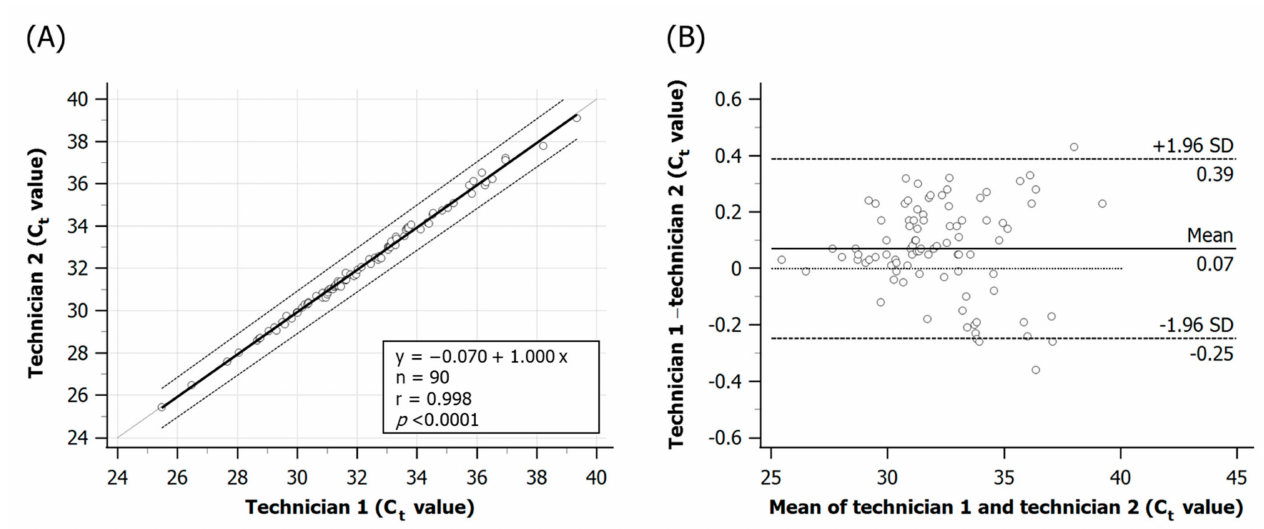
Figure 6. Comparison of the Ct values obtained during the real-time PCR analysis, performed by two technicians, using the spleen sample of red sea bream iridovirus (RSIV)-infected rock bream fish ( Oplegnathus fasciatus ). ( A ) Passing–Bablok regression analysis of the C t values obtained by technician 1 and 2 in RSIV-positive samples. ( B ) Bland–Altman analysis of the differences in the C t values obtained by technician 1 and 2. The mean C t values obtained by technicians 1 and 2 plotted against the